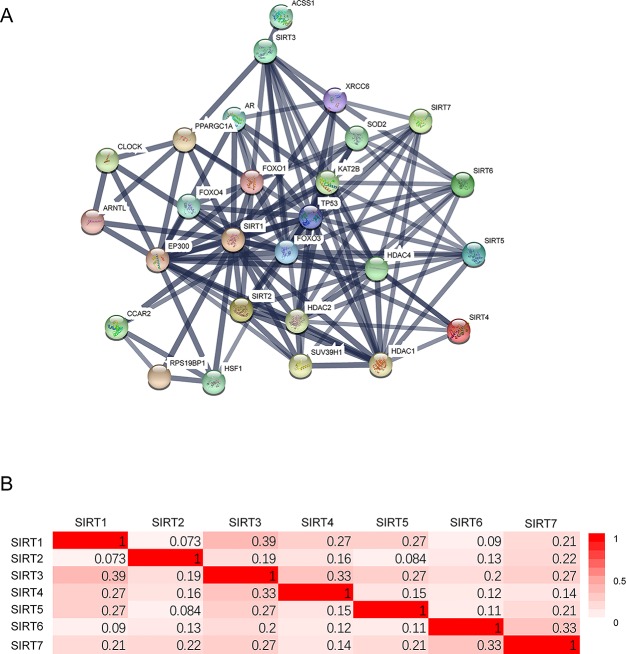
The protein–protein interaction (PPI) of SIRTs. (A) The network of 7 SIRT members and 20 proteins that significantly interacted with SIRTs (String). (B) The Pearson correlation coefficients between SIRTs (GEPIA).